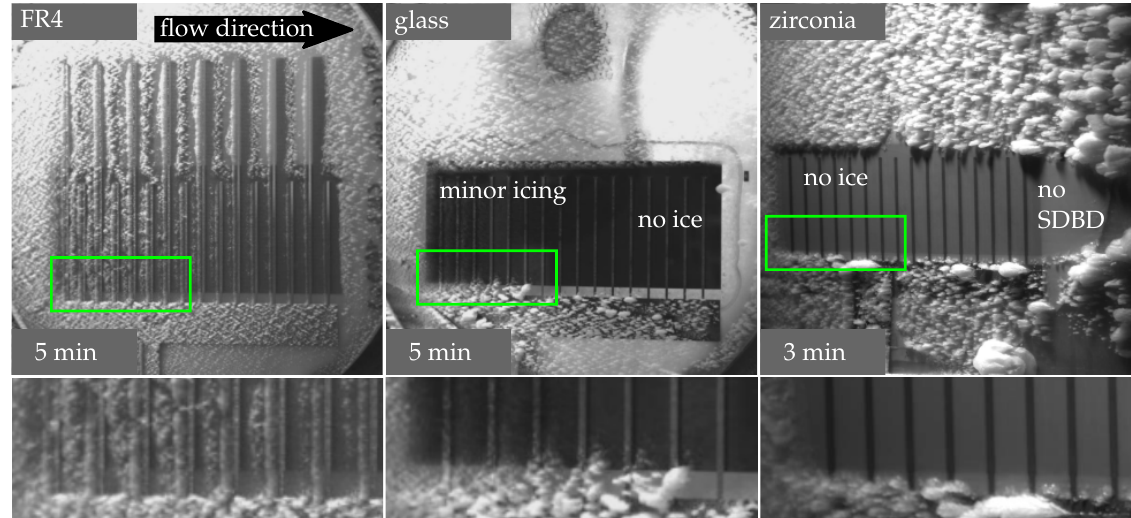
Figure 10. Images of the anti-icing experiment with the three studied materials taken with the machine vision camera from a top view during the anti-icing experiment at the times displayed in the individual lower left corners. The images below depict a magnification of the area marked in